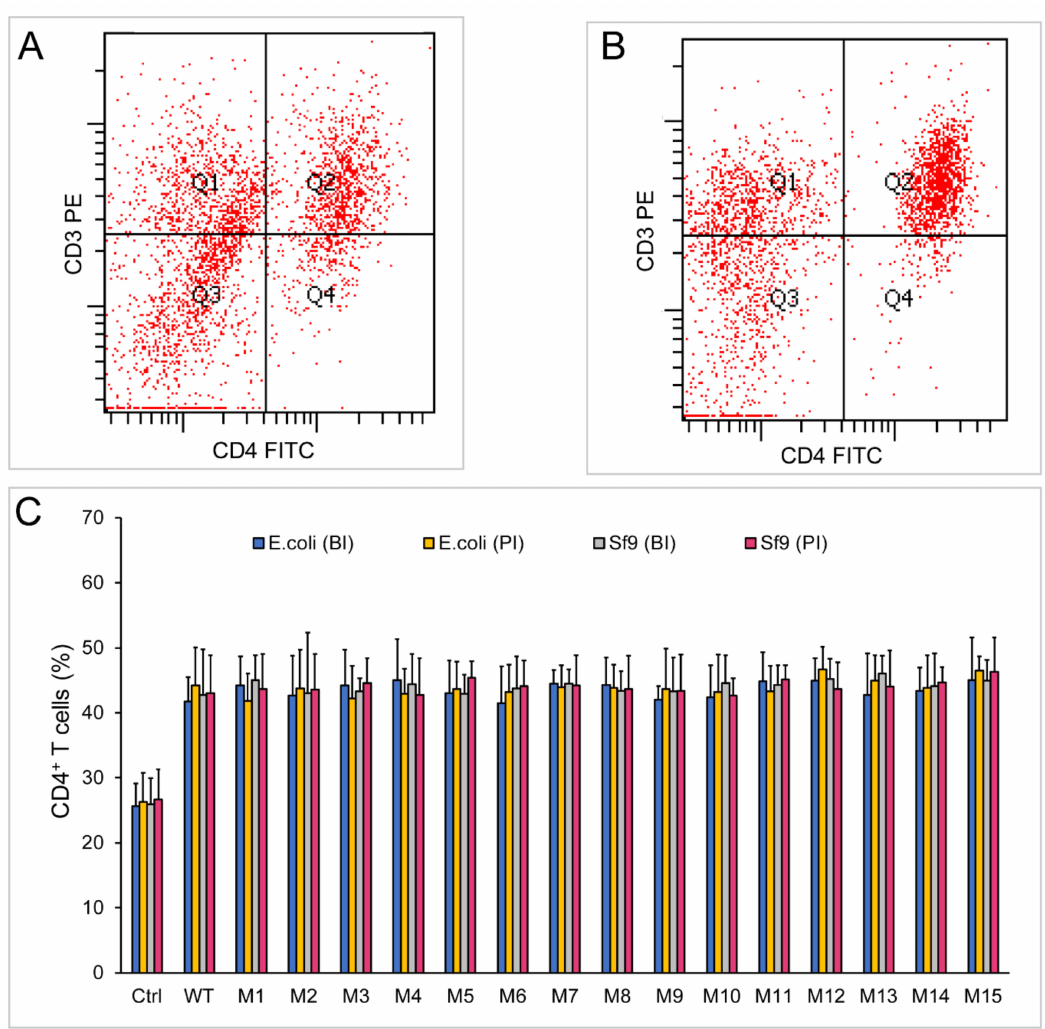
Figure 6. Stimulation assay of chIL-2 monomer and dimer in vitro. ( A ) and ( B ), immunofluorescence analysis of CD4 + T cells by flow cytometry using PE-conjugated anti-CD3 (CD3 PE) and FITC-conjugated anti-CD4 (CD4 FITC) antibodies before ( A ) or post ( B ) stimulation of chIL-2. ( C ), the bar graph of CD4 + T cell proportions. Before stimulation of T lymphocytes, each source of chIL-2 proteins was divided into two groups, one group was unincubated at 37 ◦ C (before incubation, BI), and the other group was treated with chIL-2 dimer generated from 37 ◦ C incubation (post incubation, PI). The plotted data represent mean values ± standard deviation, and are the average of three independent